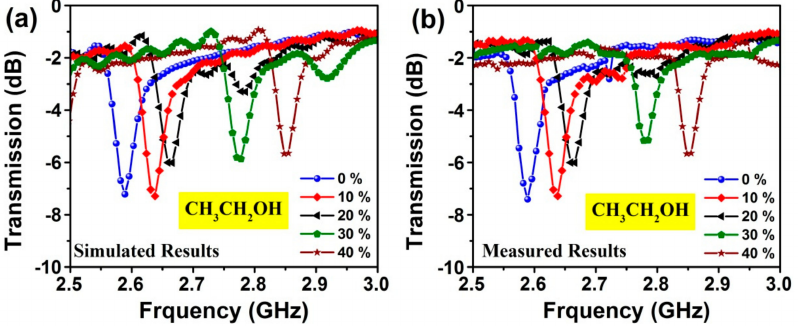
Figure 16. Dependence of transmission coe ffi cient on the ethanol (CH 3 CH 2 OH) concentration over 2.5–3 GHz: ( a ) simulated; ( b ) measured